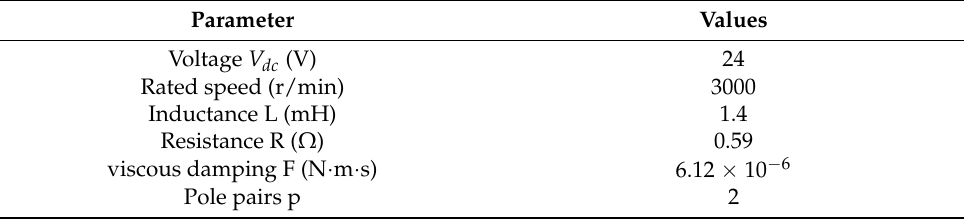
Table 3. The 57BL55S06 series PMSM